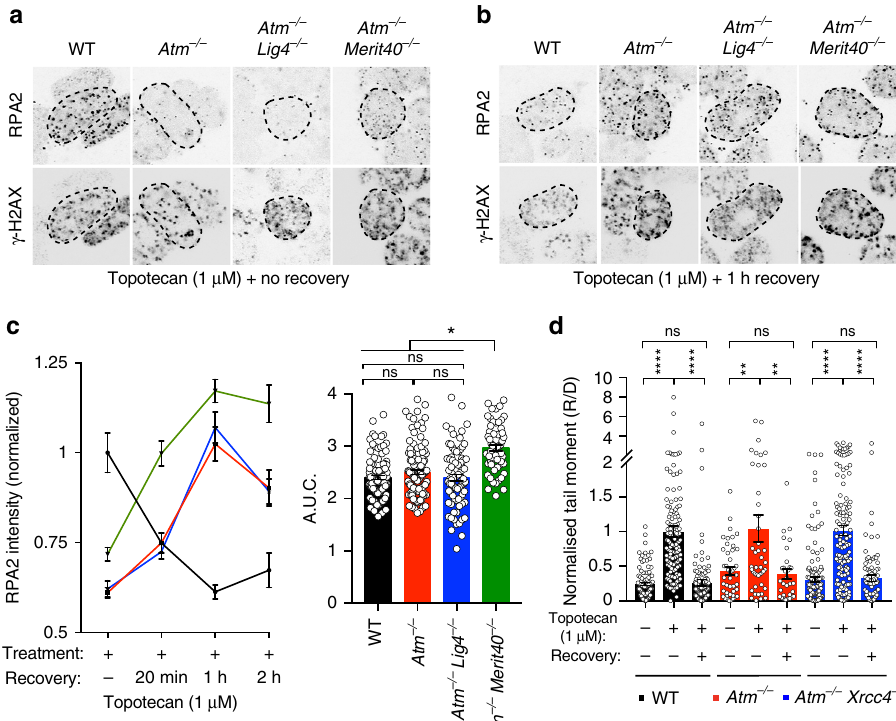
Fig. 6 ATM-de fi cient cells can execute resection and do not accumulate unrepaired seDSBs upon topotecan treatment. a , b Representative images used for quanti fi cation of RPA2 foci accumulation in γ H2AX-positive nuclei. Atm − / − Lig4 − / − and Atm − / − Merit40 − / − cells are compared to WT and Atm − / − cells upon topotecan treatment for 1 h ( a ) or 1 h after topotecan was removed ( b ). For better visualization, color images were inverted in black and white; representative color images for all time points are presented in Supplementary Figure 7. Dashed outline indicates periphery of nuclei based on DAPI staining. c Quanti fi cation of topotecan-induced RPA2 foci formation, showing an initial delay in seDSB end resection in Atm − / − ( n = 122) and Atm − / − Lig4 − / − ( n = 77) cells compared to WT ( n = 110) cells (no recovery time point), but a recovery in resection during the 2-h timeframe after topotecan withdrawal. Overall, Atm − / − Merit40 − / − cells ( n = 57) show signi fi cantly higher resection when compared to all the other genotypes. RPA2 intensity quanti fi cations were analyzed exclusively in γ H2AX-positive nuclei, representing S-phase cells that had encountered topotecan-induced TOP1- DNA cleavage complexes during replication. Cells were treated for 1 h with 1 µ M topotecan and recovered for 20 min (20 min), 1 h, or 2 h without the drug. Graphs quantifying RPA intensity (left) and AUC (right) were generated by using GraphPad Prism 7. Bars represent mean ± s.e.m.; **** p < 0.0001; NS = not signi fi cant ( p > 0.05); two-tailed Student ’ s t test following F test to con fi rm equal variance; df = 4. Data from n = 3 individual experiments. d Neutral comet assays showing similar DNA damage generation and repair patterns upon seDSB induction in WT ( n = 86), Atm − / − ( n = 32), and Atm − / − Xrcc4 − / − ( n = 89) cells. Cells were treated for 1 h with 1 µ M topotecan, the drug removed, and cells allowed to recover for a further 6 h. Bar graphs represent the mean ± s.e.m. of the normalized ratio of recovery to damage (R/D) tail moments. The graph was generated by using GraphPad Prism 7; **** p < 0.0001; ** p < 0.01; NS = not signi fi cant ( p > 0.05); two-tailed Student ’ s t test following F test to con fi rm equal variance; df = 4. Source data are provided as